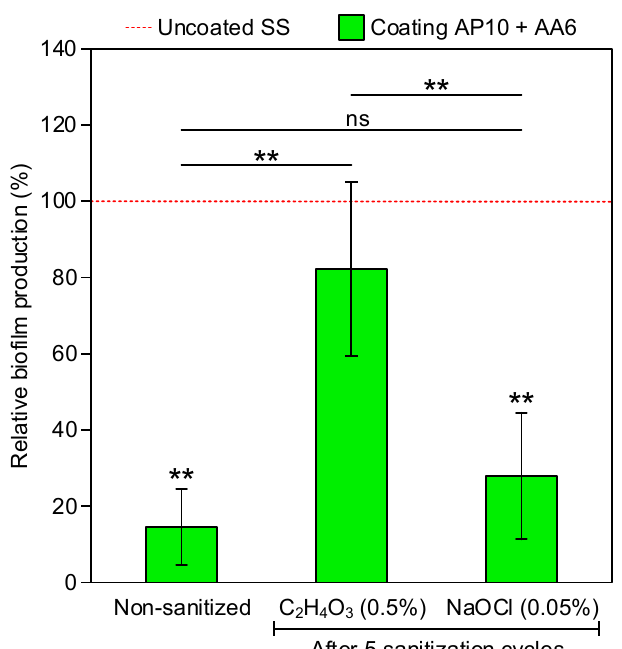
Figure 1. Relative biofilm production of the three-strain L. monocytogenes cocktail on uncoated SS and on the coating under the three different sanitization scenarios. The 100% relative biofilm production in each sanitization scenario corresponds to the biofilm formation observed on the uncoated SS plates. Statistically significant relationships ( p < 0.05) are indicated with asterisks (**, p < 0.01).